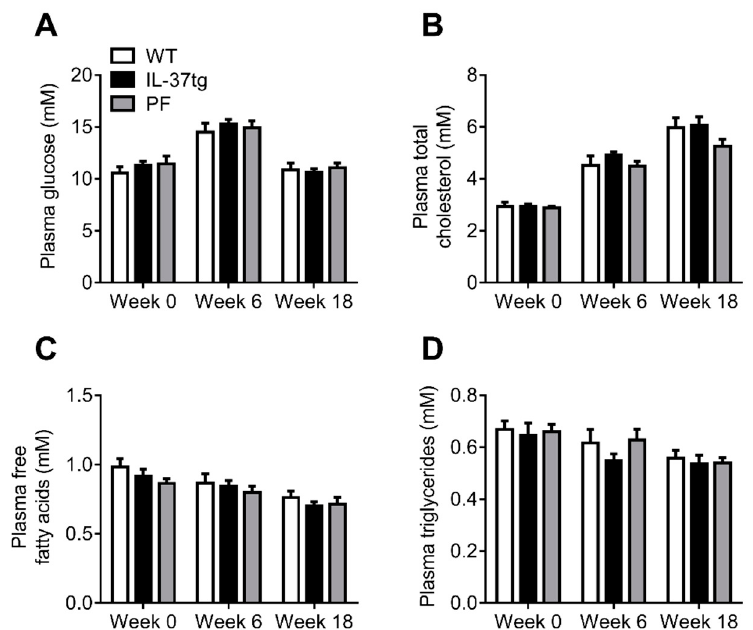
Figure 3. Heterozygous IL-37 expression does not affect plasma glucose and lipid levels. 10-week old male C57Bl/6J mice and heterozygous IL-37tg mice on a C57Bl/6J background were fed a high-fat diet (HFD) for 18 weeks. Pair-feeding of wild-type (WT) mice (PF group) was initiated after 5.5 weeks of HFD feeding. Plasma glucose ( A ), total cholesterol ( B ), free fatty acids ( C ) and triglycerides ( D ) were measured at indicated time points. Values represent means ± SEM ( n = 10 animals per group).